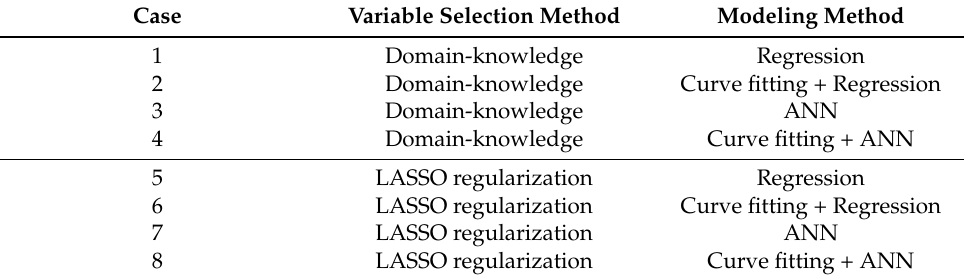
Table 6. Comparison of model